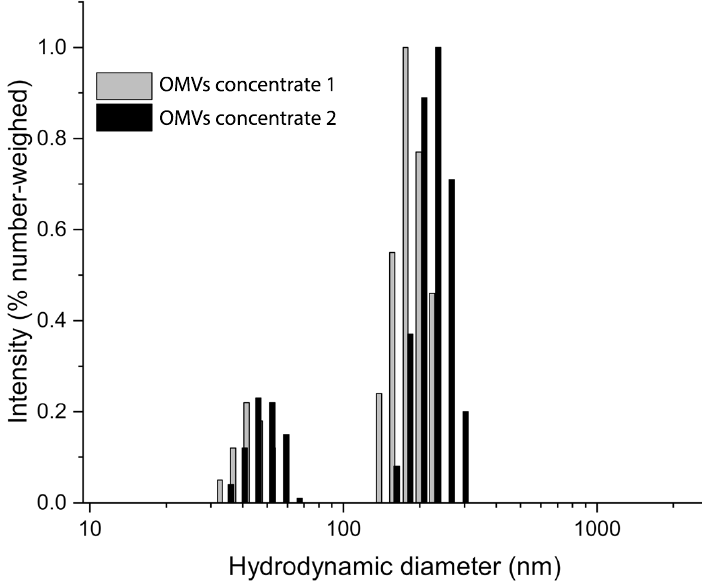
Figure 2. DLS analysis of OMVs concentrates 1 and 2. Samples were tested at 20 °C in a 0.22 µm filtered PBS medium. The hydrodynamic size distributions show two nearly overlapping populations at about 50 and 150 nm indicating size similarity of the OMV samples tested.